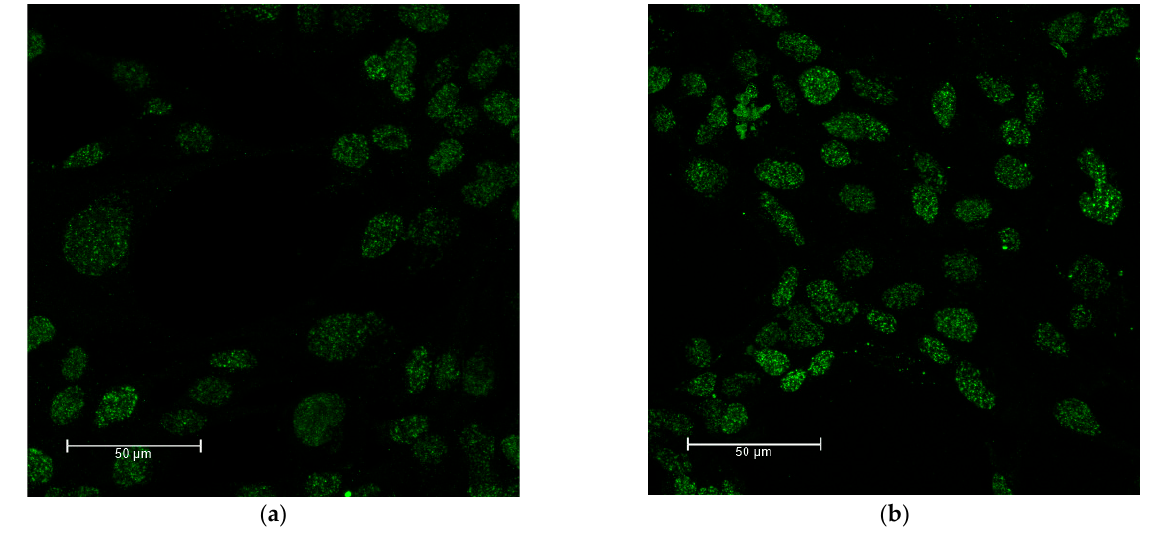
Figure 12. 𝛾 -H2AX characterization with green representing double-strand break foci. Images are a stack of 50 individual slices at 63× magnification taken from the first instance of foci to the last